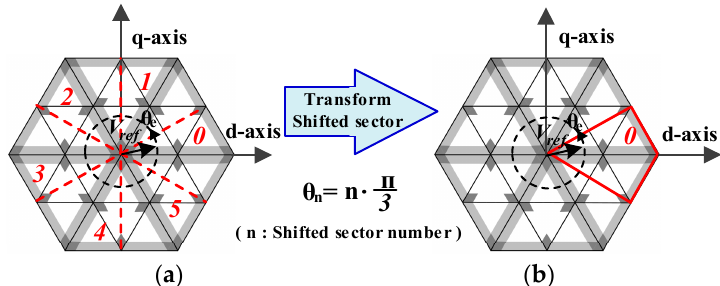
Figure 16. Transform shifted sector. ( a ) Shifted sectors (0~5); ( b ) shifted sector (0).